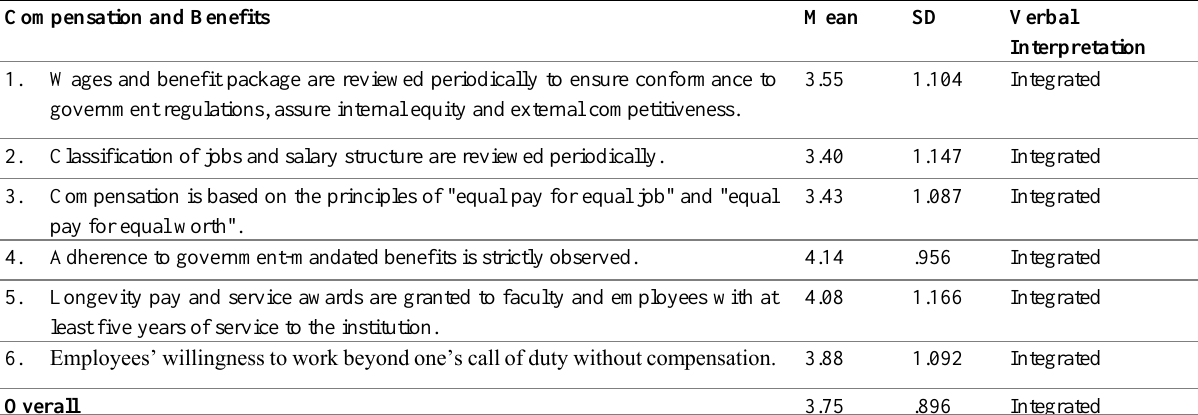
Table 3: Extent of Integration of Integrity to Compensation and Benefits as Perceived by Respondents Compensation and Benefits Mean SD Verbal